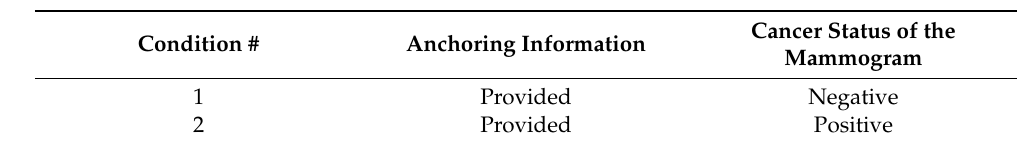
Table 1. Experimental conditions in Study